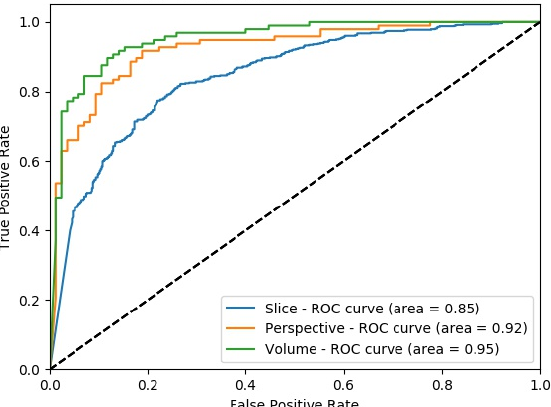
Figure 30. SFMPF model using LOG image—comparison of ROC curve for slice, perspective, and volume-level classifications for the slices from YZ-perspective.